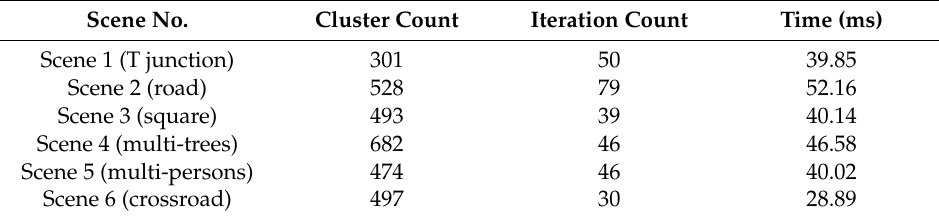
Table 1. Detail information of clustering results in di ff erent scenes Scene No. Cluster